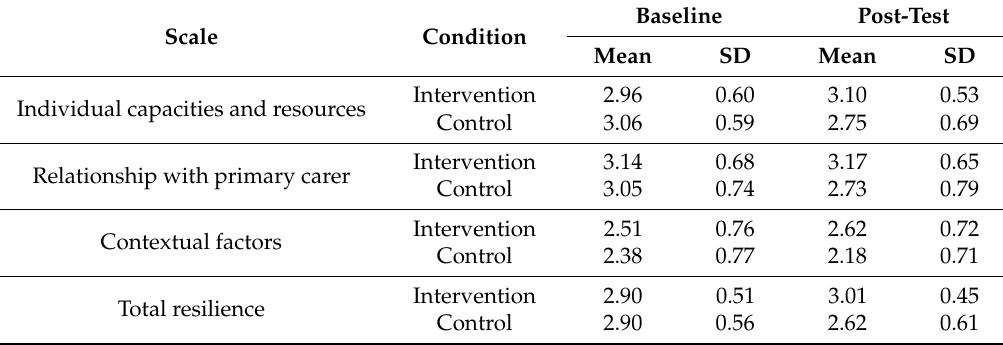
Table 5. Means and standard deviations for CYRM-28 resilience scales by experimental condition. Scale